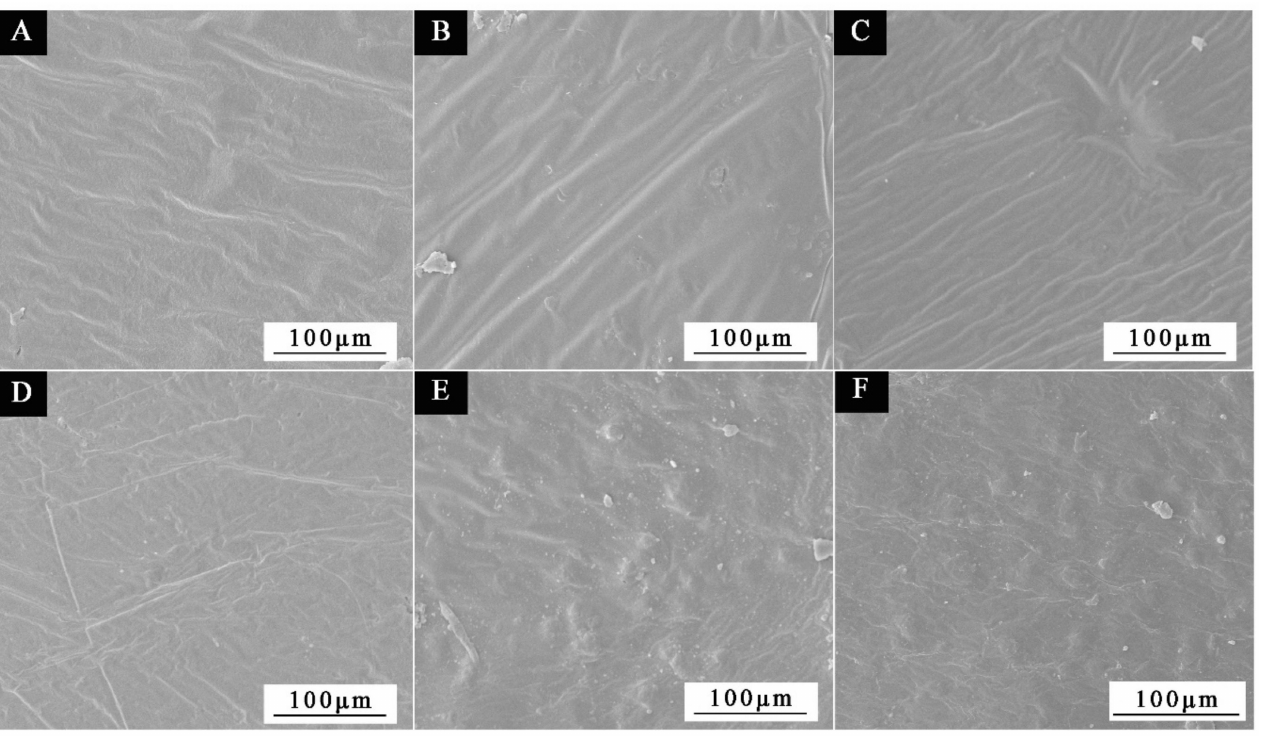
Figure 14. Coating film SEM pictures before antibiosis: ( A ) 0#, ( B ) 2 (cid:48) #, ( C ) 3 (cid:48) #; coating film SEM images before antibiosis: ( D ) 0#, ( E ) 2 (cid:48) #, ( F ) 3 (cid:48)